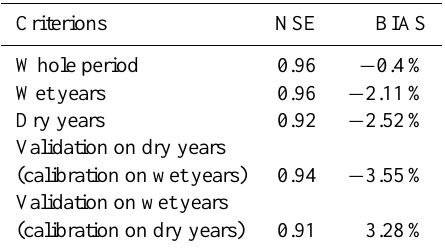
Table 2. Calibration/validation results for the hydrological model.